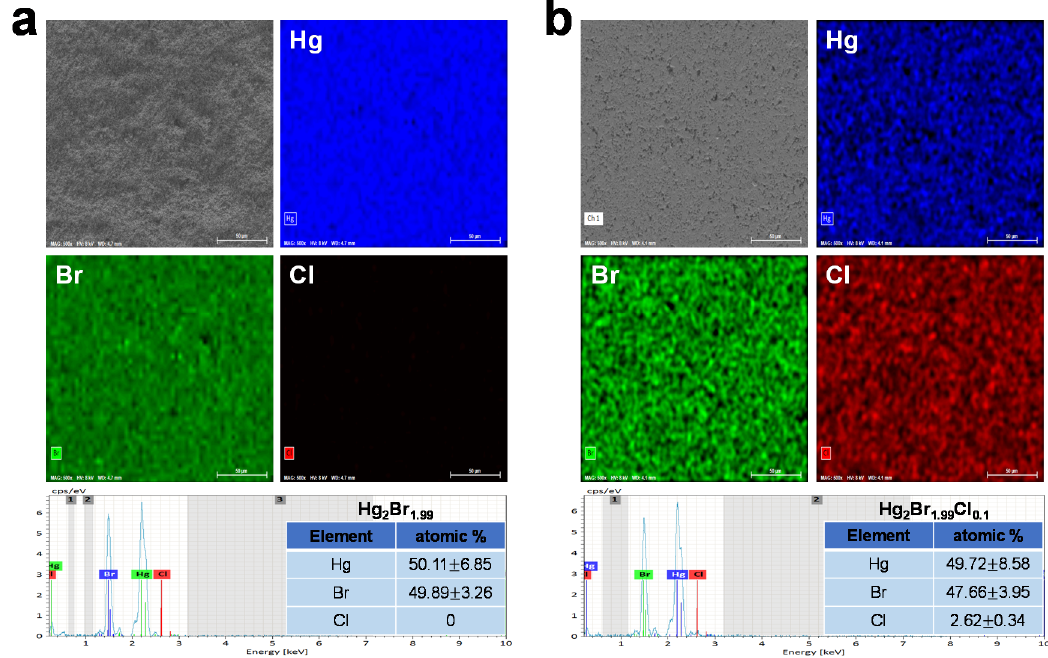
Figure 1. The scanning electron microscopy / energy-dispersive spectroscopy elemental maps and spectrum analysis of ( a ) Hg 2 Br 2 and ( b ) Hg 2 Br x Cl 2−x.